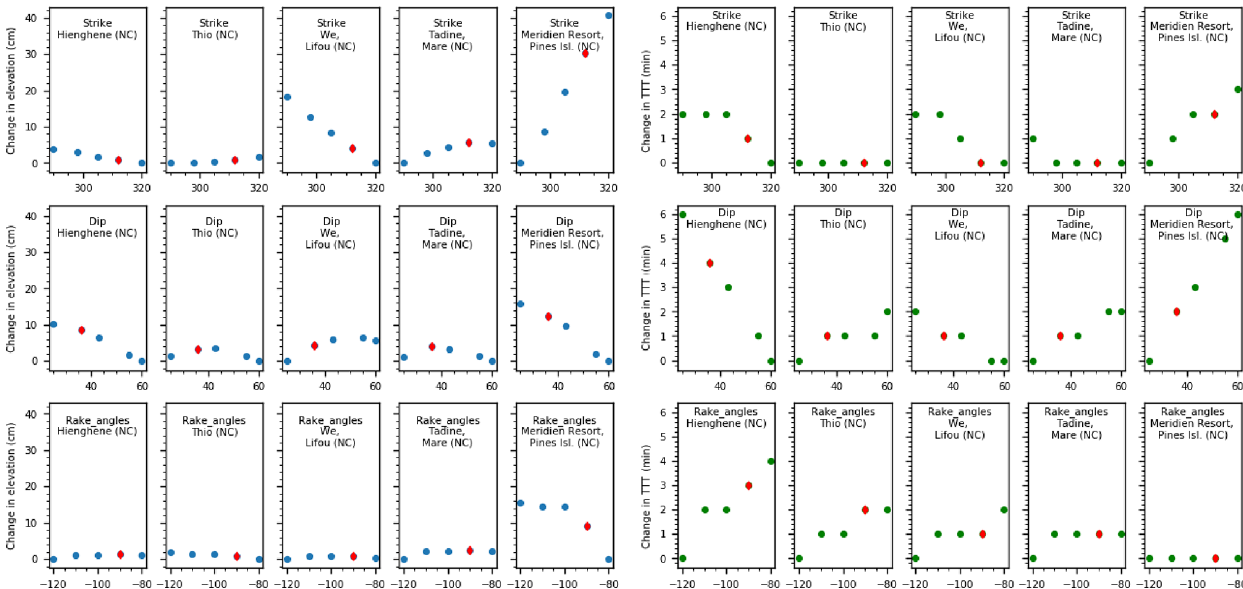
Figure 9. Examples of relationship between H max (left panels) or TTT (right panels) and the fault deformation angle (strike, dip or rake). Results are extracted from the sensitivity tests at four places located in New